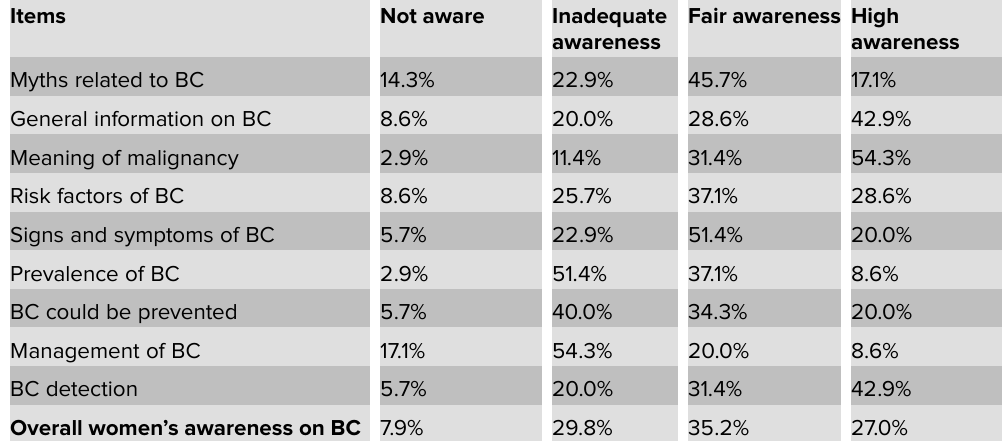
Table 2: Women’s awareness on breast cancer at Al-Baha region, n =